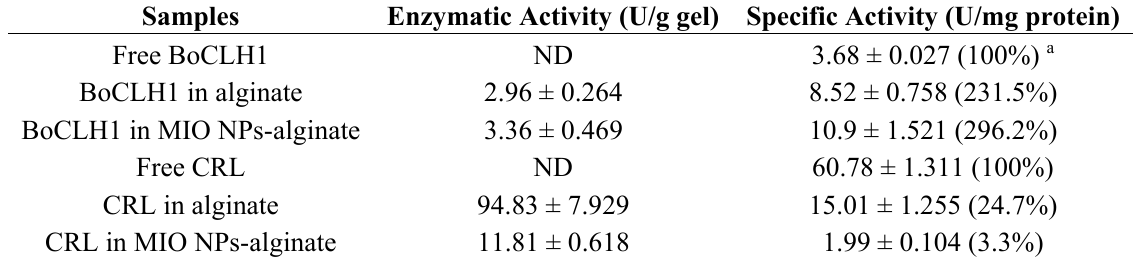
Table 2. Hydrolytic activity of entrapped BoCLH1 and CRL in alginate beads or MIO NP-alginate composite